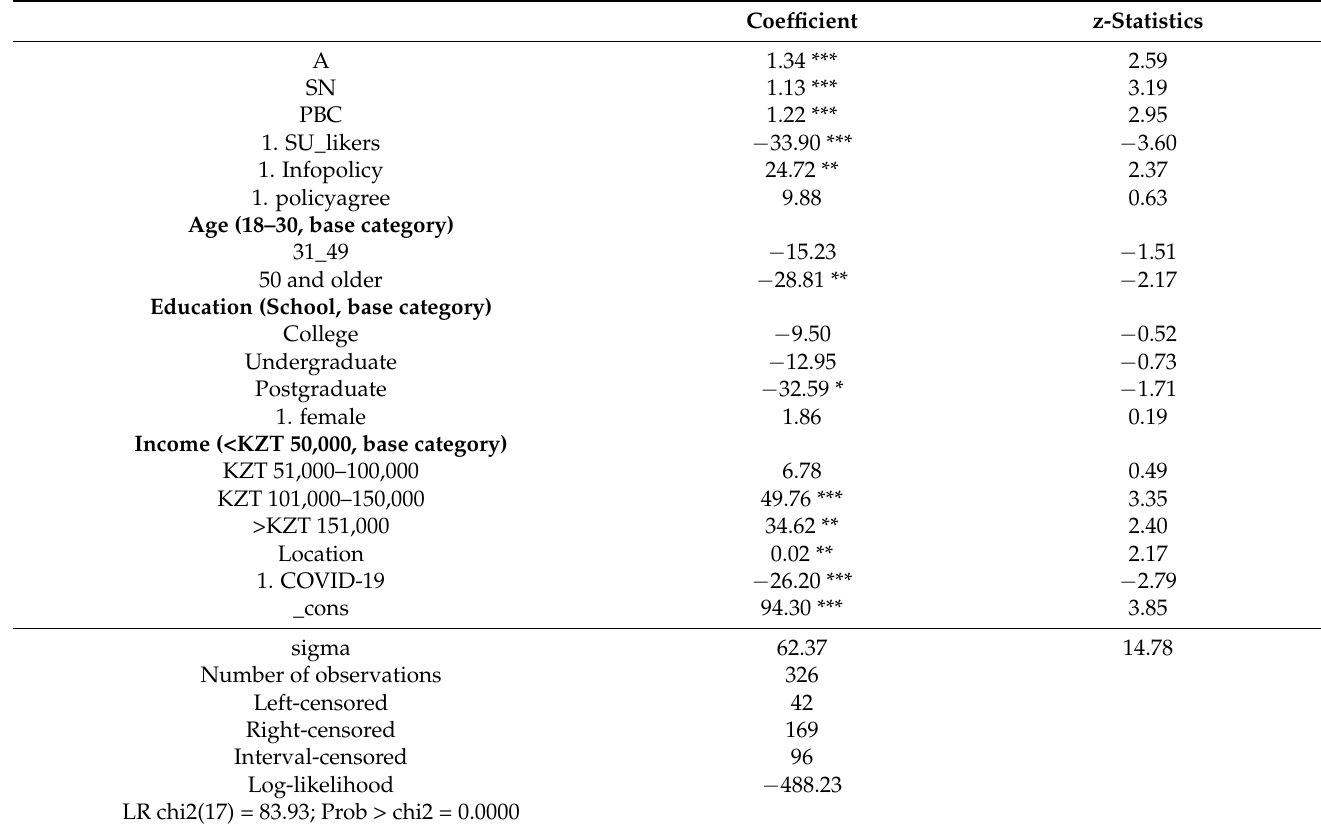
Table 6. Results of the interval